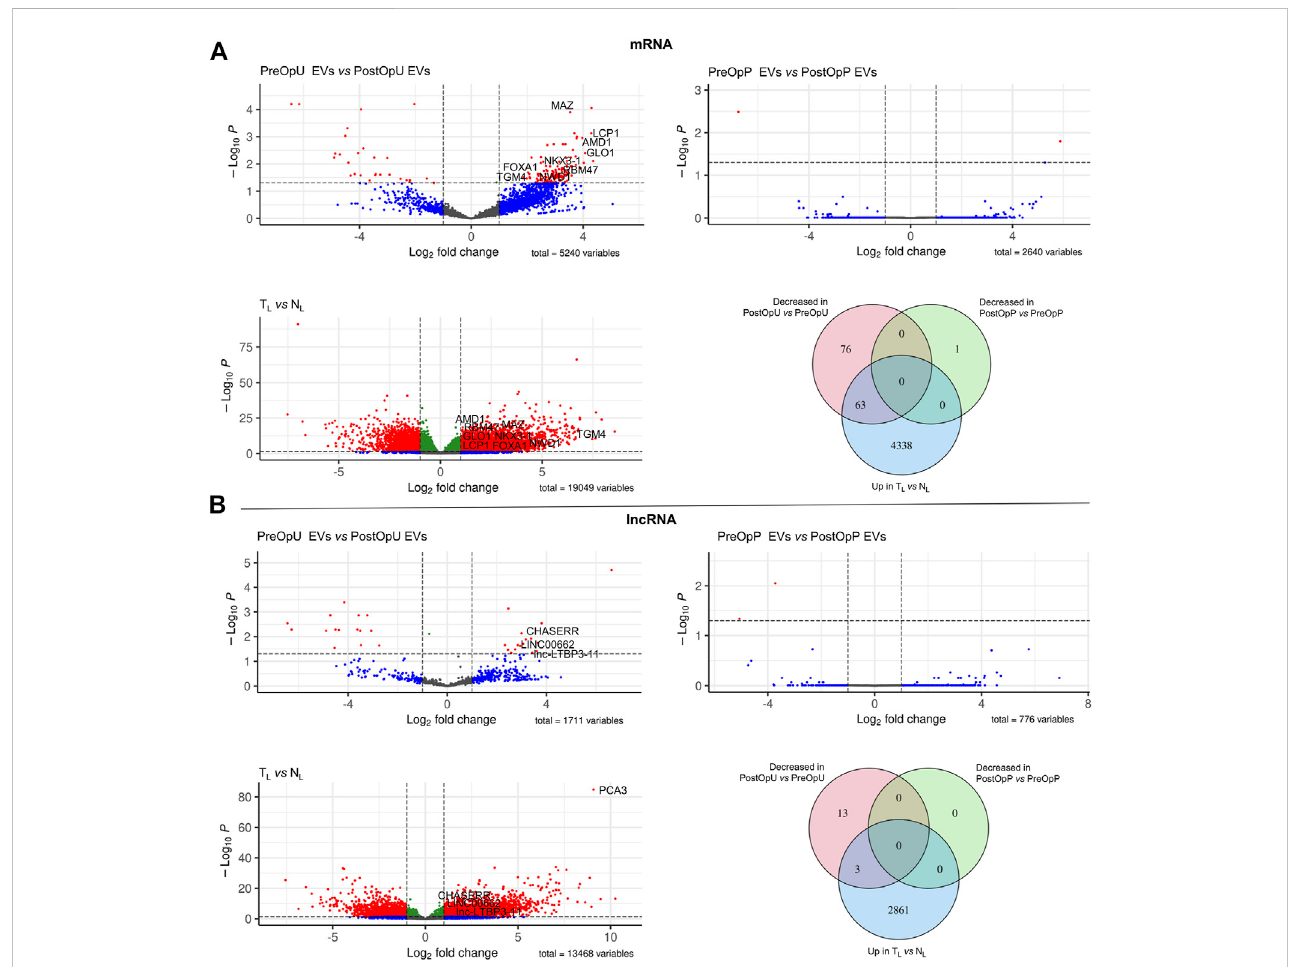
FIGURE 4 DifferentialexpressionanalysisoflongRNAs. (A) DifferentialexpressionanalysisofmRNAsand (B) lncRNAs.Volcanoplotsdepictsigni fi cantdifferencesin the pre-operation urinary or plasma EVs as compared to the post-operation EVs, and in full transcriptome libraries prepared from tumor (T L ) and normal prostate tissues (N L ). Venn diagrams show the numbers of mRNAs and lncRNAs overexpressed in tumor tissues vs. normal prostate tissues (Up in T L vs. N L ), decreased inthepost-operationurinaryEVs as compared to pre-operationurinaryEVs and decreased inthepost-operationplasmaEVs as compared to pre-operation plasma EVs (Log2FC > 1 and adj. p -value ≤